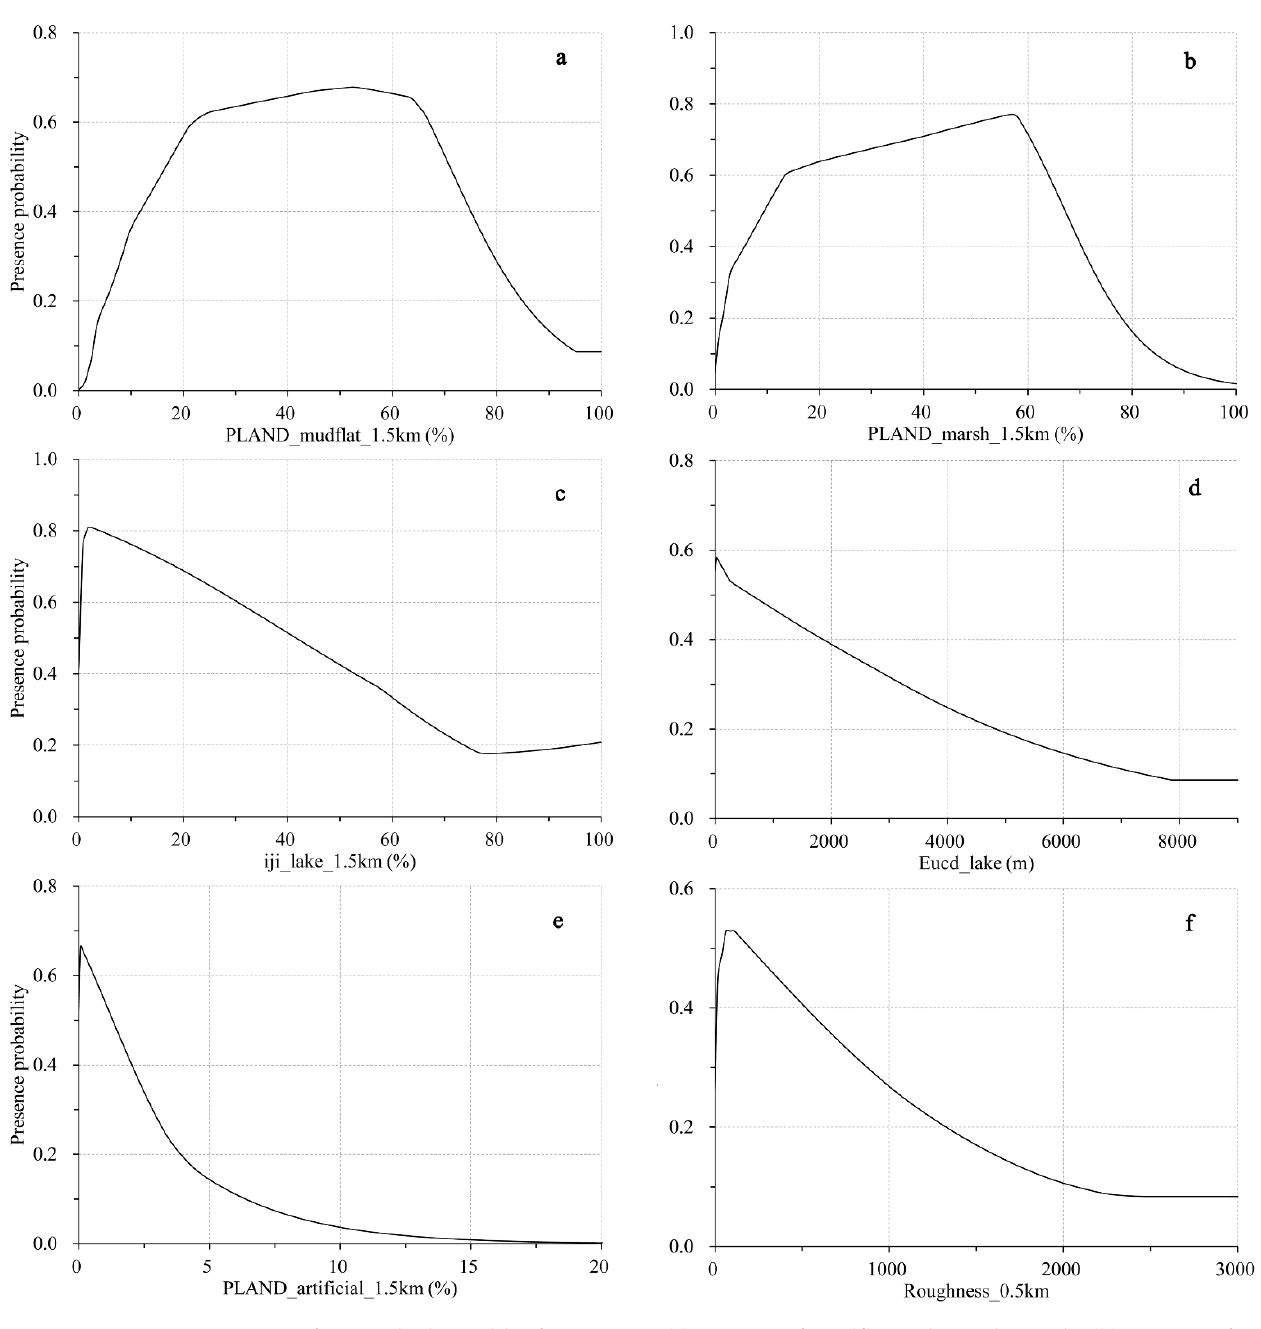
Figure 5. Response curves of top ranked variables for roosting. ( a ) PLAND of mudflat at the 1.5-km scale, ( b ) PLAND of marsh at the 1.5-km scale, ( c ) IJI of lake at the 1.5-km scale, ( d ) distance to lake, ( e ) PLAND of artificial surfaces at the 1.5-km scale and ( f ) surface roughness at the 0.5-km scale.